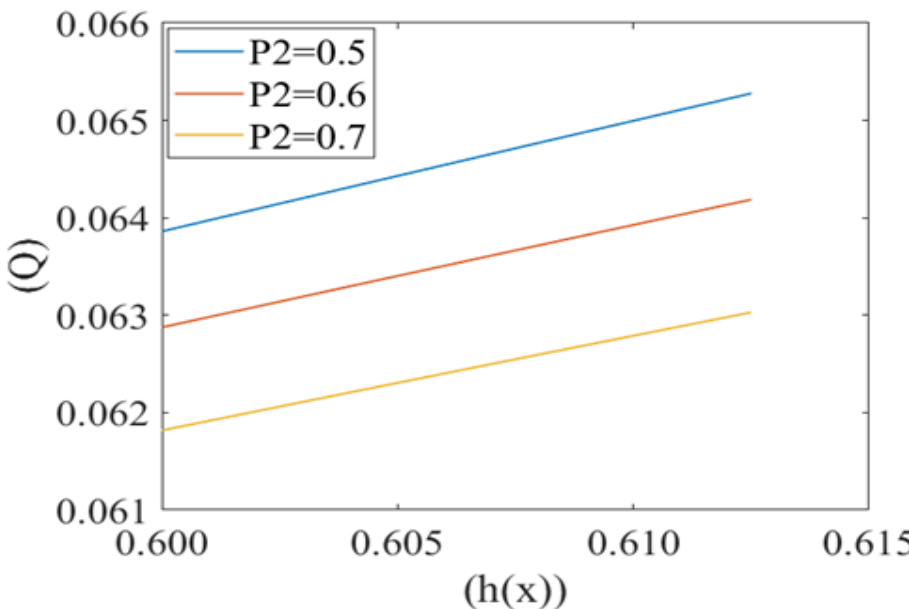
Figure 8. Variation of flux per unit length in backward direction (leak back ( Q )) with the height of plasma film h(x) at different local pressures ( P2 ) with Re = 0.25, k = 0.1.